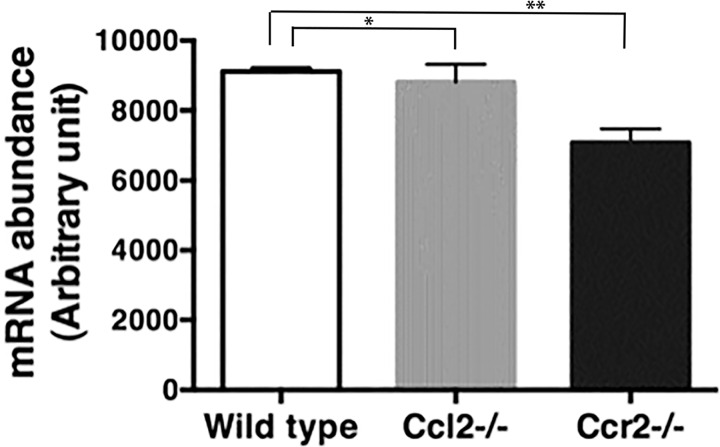
Csfr1 mRNA is reduced in monocytes from Ccr2-/- mice.Monocytes were purified from the blood of wild type, Ccl2-/-, and Ccr2-/- mice (5 mice in each group). mRNA was isolated and mRNA encoding CSF-1R was quantified by PCR. * p > 0.05 by t-test; ** p < 0.05 by t-test.